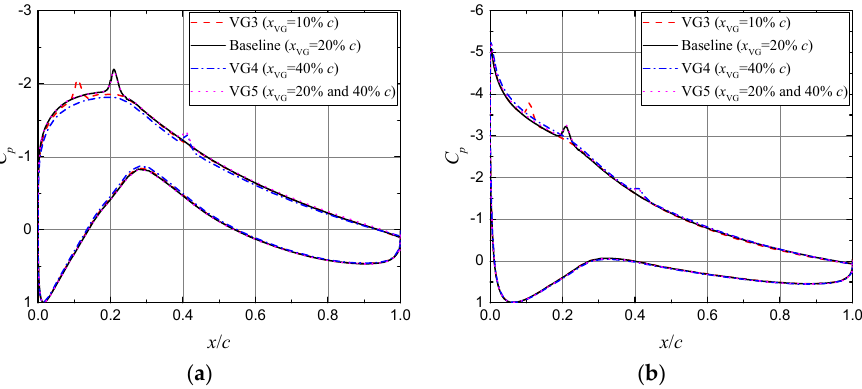
Figure 19. Pressure distributions of the airfoil with different VGs in chordwise installation. ( a ) α = 5 ° (min.); ( b ) α = 15 ° (max.).